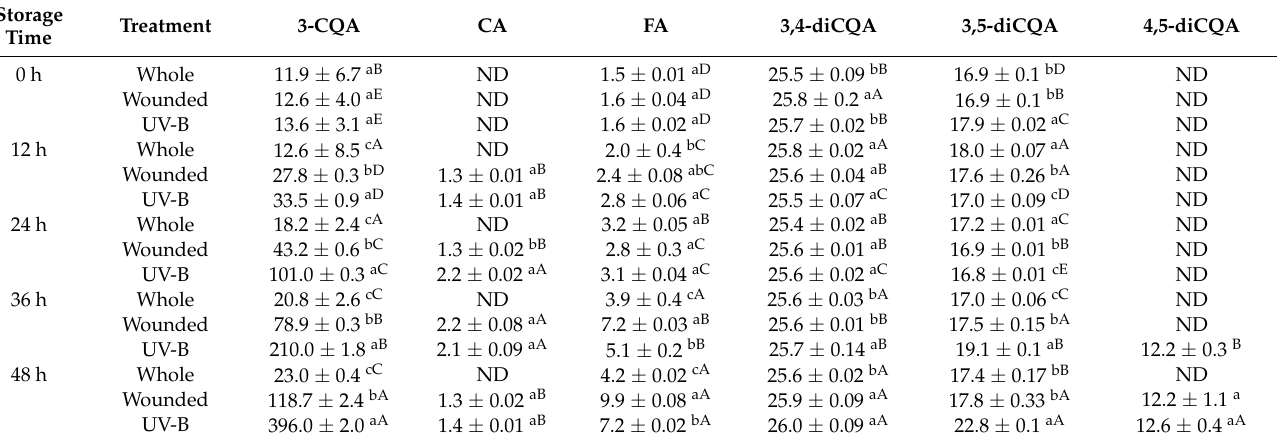
Table 1. Individual phenolic compounds concentrations of whole, wounded and UV-B–treated carrots during storage at 15 ◦ C for 48 h (mg Kg − 1